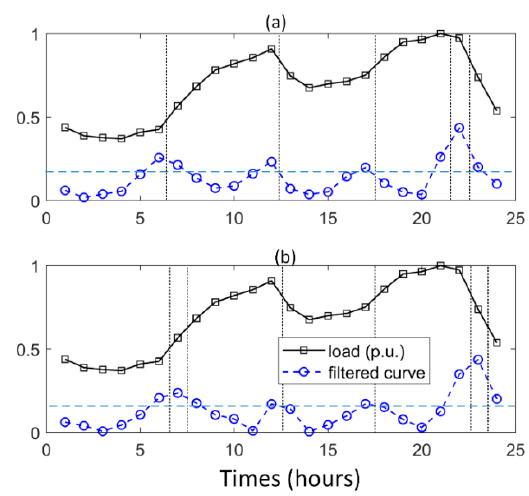
Figure 4. Segmentation of integrated load curve in case 2 ( a ) and case 3 ( b ).